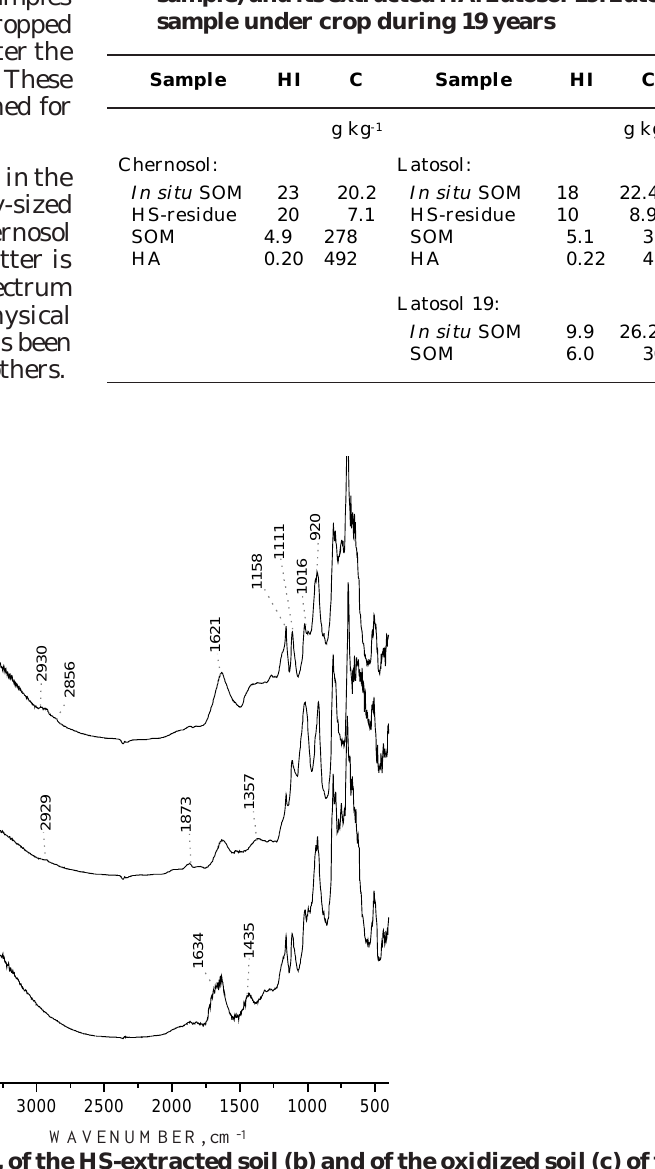
Table 1. Hydrophobicity Index (HI) and C content of the in situ SOM, of the HS-residue (residue